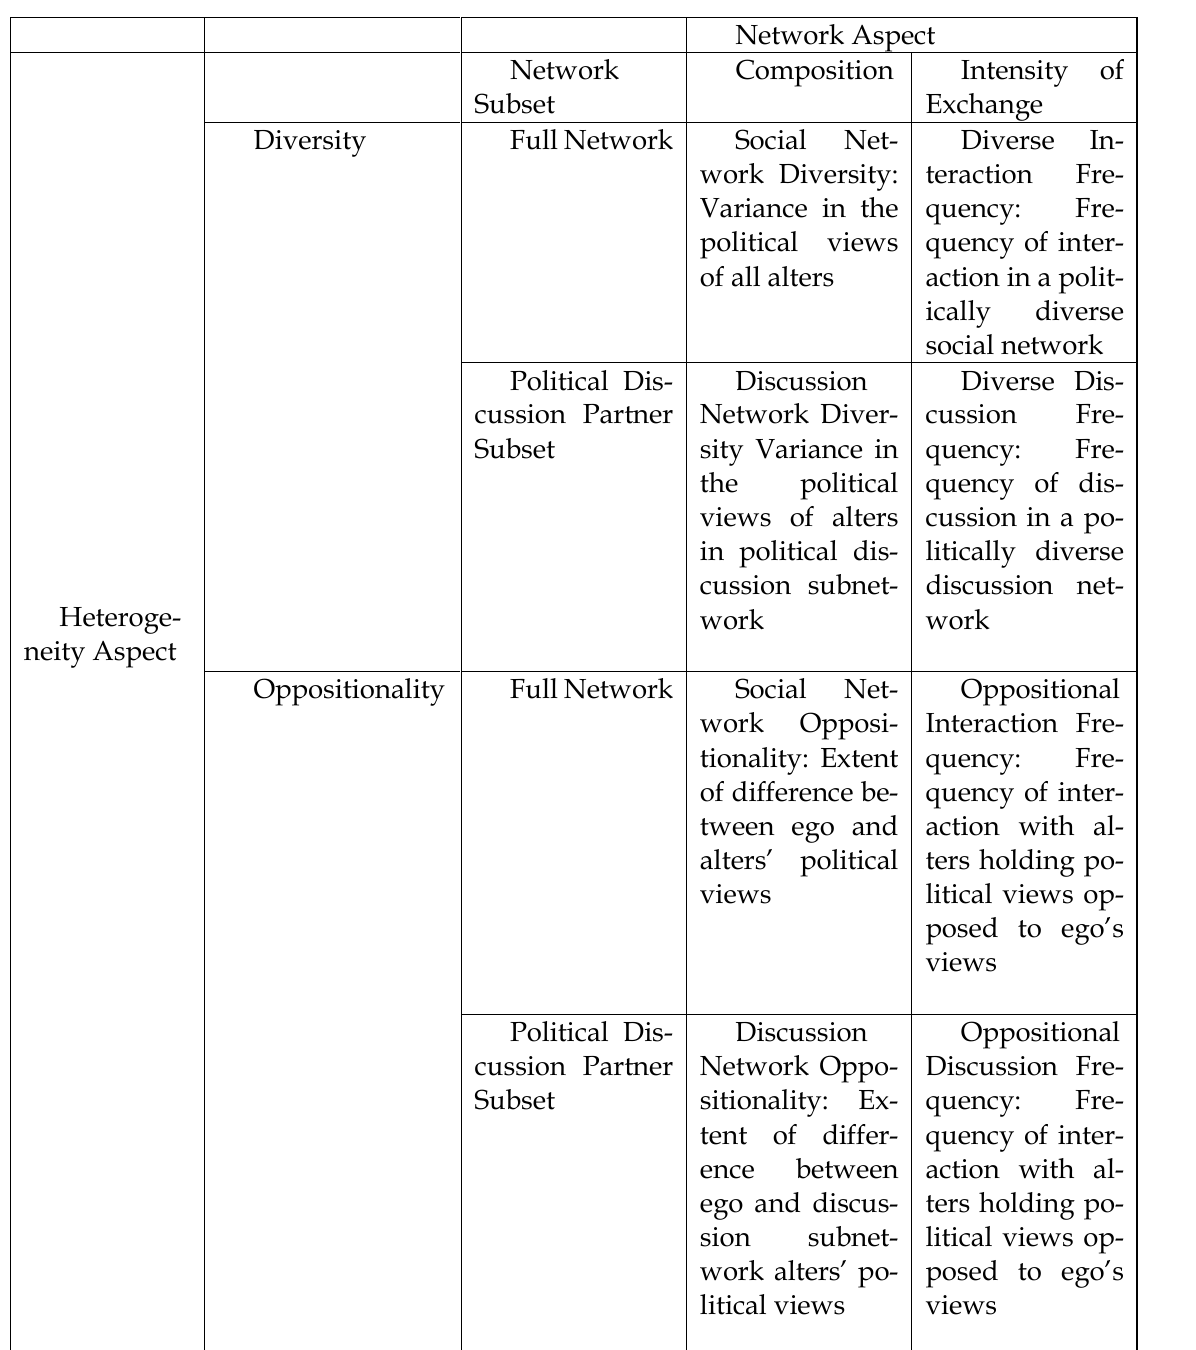
Table 1. Social Network Heterogeneity